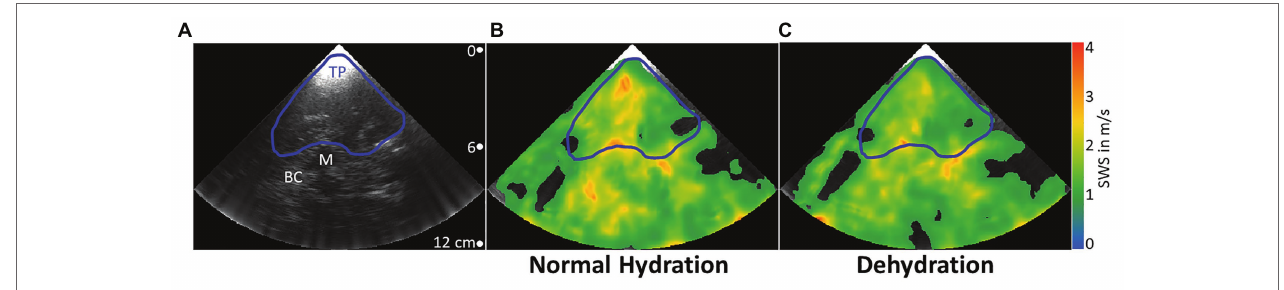
FIGURE 3 | Representative B-mode image and elastograms in normal hydrated and dehydrated states. Transcranial B-mode image (A) . Typical landmarks are the temporal parenchyma (blue line, TP), where ROIs were drawn, the mesencephalon (white line, M), which was used as the most prominent landmark, and basal cisterns (BC), a highly vascularized area around the mesencephalon with high echogenicity. Elastograms are shown as color-coded shear wave speed (SWS) maps. In the normally hydrated state (B) , mean SWS in the demarcated region of interest is higher than in the dehydrated state (C)